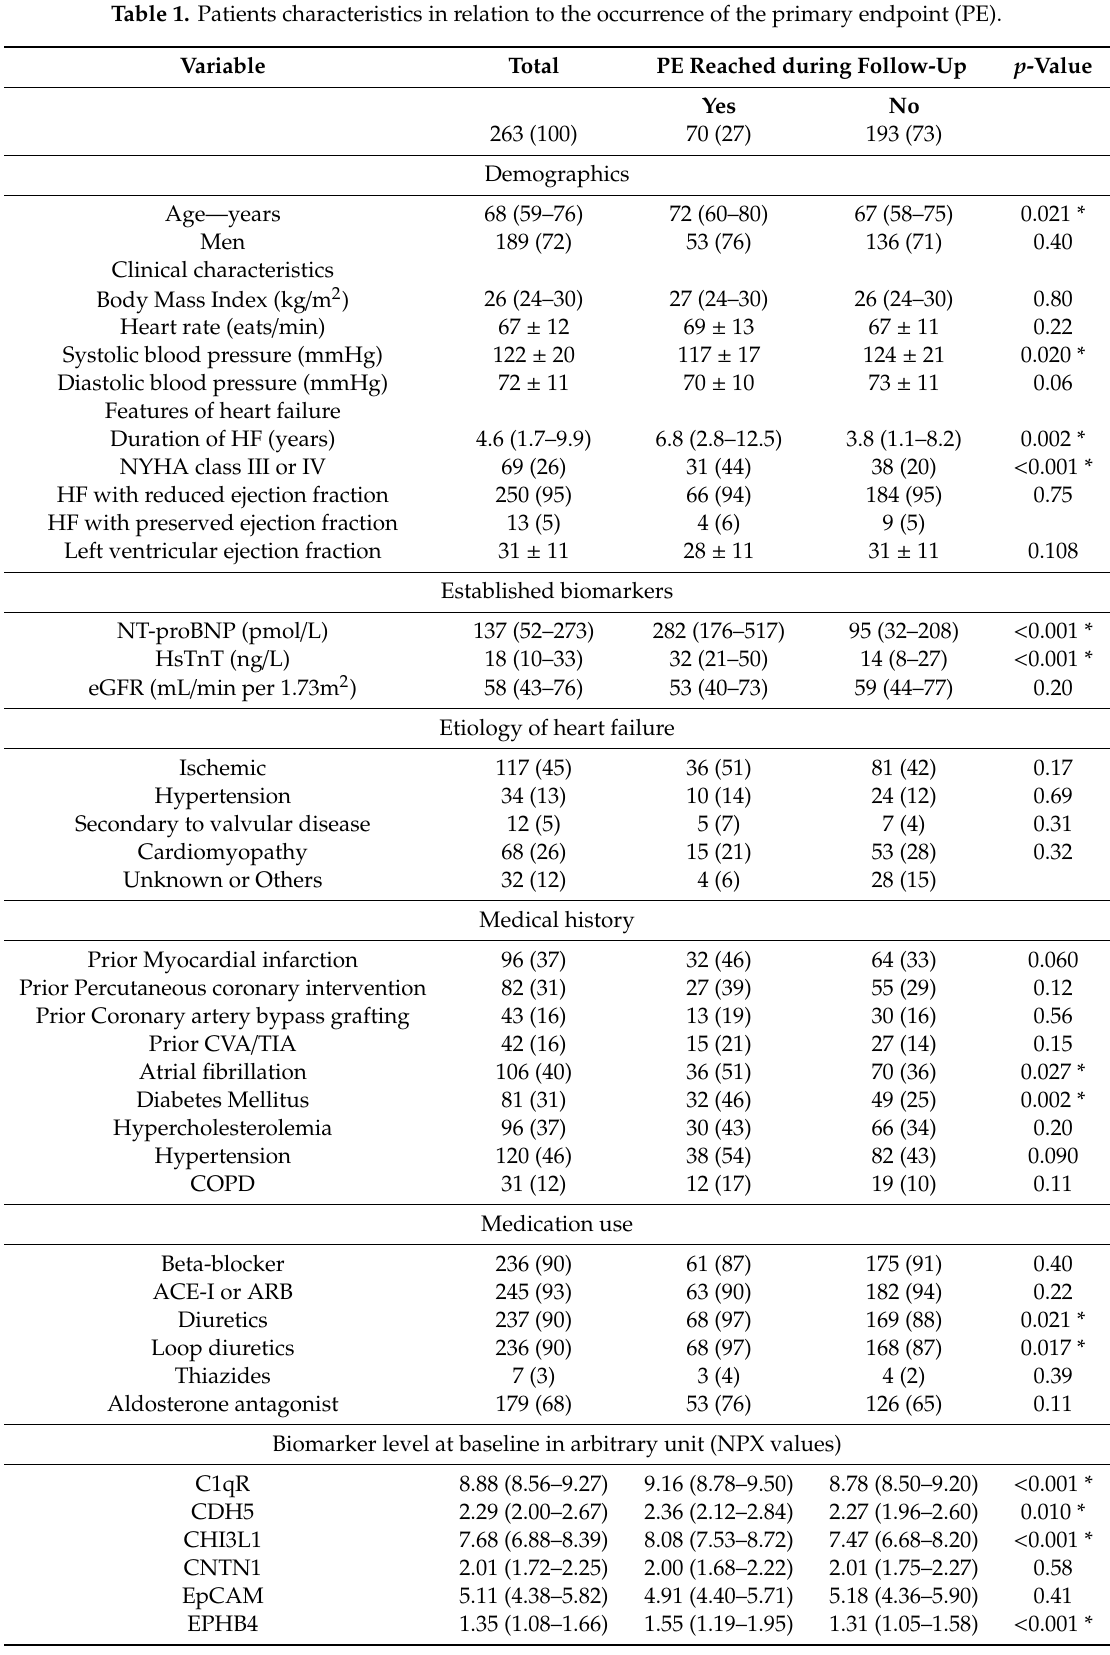
Table 1. Patients characteristics in relation to the occurrence of the primary endpoint